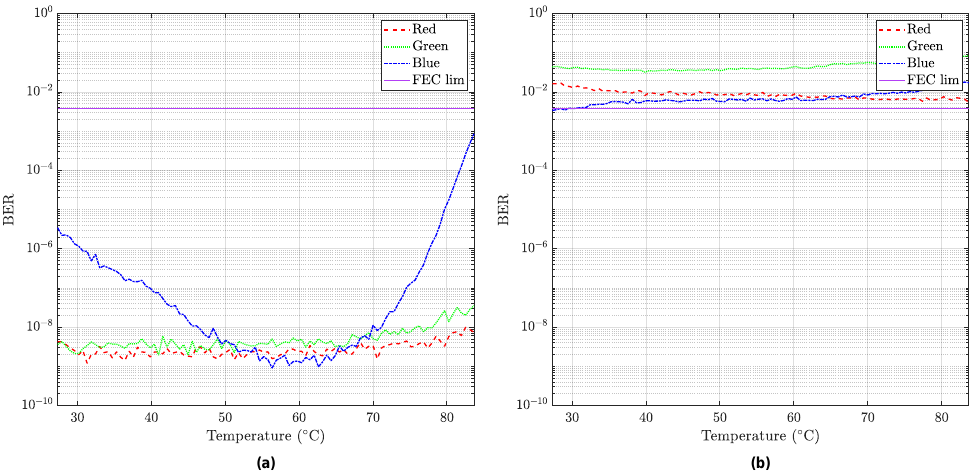
Figure 14. BER at different temperatures, compensating the channel using the CSI corresponding to 60°C and with a medium SNR value (20 dB). ( a ) Sony IMX249 and ( b ) Foveon X3. Dashed line, dotted line, and dash-dot line correspond to red, green, and blue,